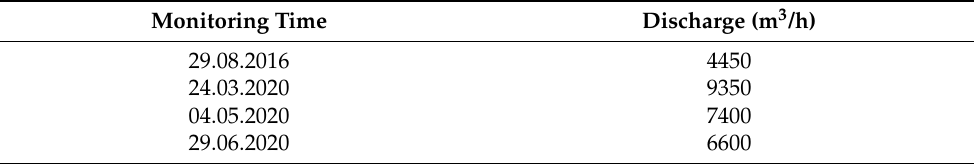
Figure 6. Brine leakage from the evaporation ponds based on mass balance calculations. The leakage for the years 1985–2002 is based on the Dead Sea Works calculations, conducted for their production reports. The leakage for the years 2003–2018 is based on recalculations of mass balance (Supplementary Materials Table S3). The dashed black line represents the time-step approximations used for the numerical model. Table 1. Measured brine discharge rates at the marine canal.